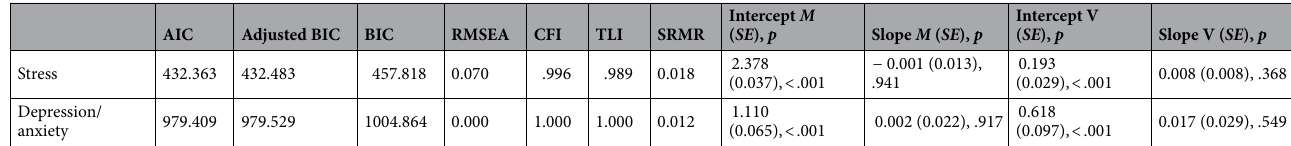
Table 2. The model fit information and descriptives for the LGC models for stress and depression and anxiety (N = 178). LGC Latent Growth Curve, AIC Akaike Information Criterion, BIC Bayesian Information